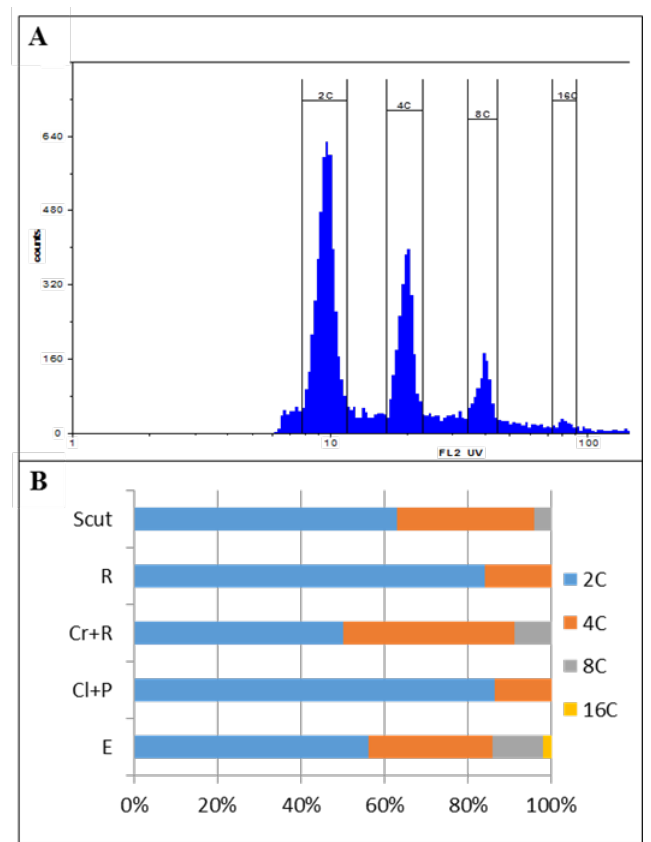
Figure 2. Flow cytometry analysis of DNA content pattern in the Brachypodium embryos that were isolated at 4 h after imbibition (HAI) ( A ). Histogram showing the ploidy distribution in whole embryos. ( B ) Percentage of cells with a 2C, 4C, 8C, and 16C DNA content in a whole embryo (E) and in specific embryo organs, (Scut) scutellum, (R) radicle, (Cr + R) coleorhiza and radicle, (Cl + P) coleoptile with a shoot apex and primary leaves.